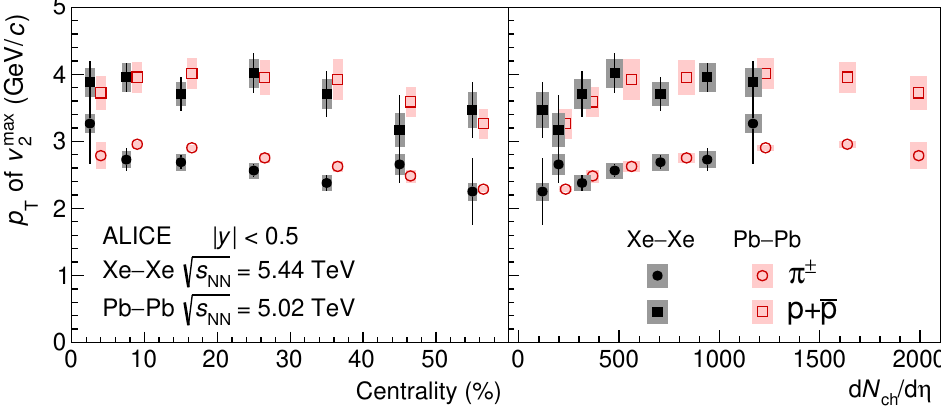
Figure 14. The p T | v max for π ± and p+ p (black markers) compared to ALICE measurements √ 2 performed in Pb-Pb collisions at s NN = 5.02 TeV [32] (red markers) as a function of centrality (left) and charged-particle density (right) [73, 74]. The Pb-Pb points are slightly shifted along the horizontal axis for better visibility in both panels. Bars (boxes) denote statistical (systematic)